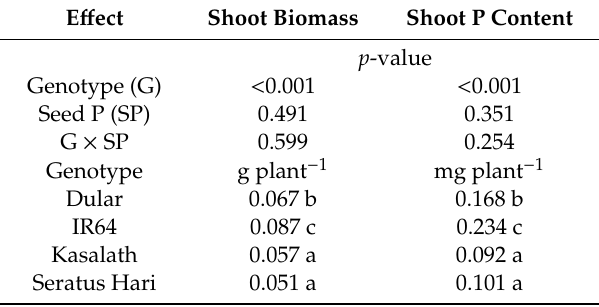
Table 3. ANOVA results for shoot biomass and shoot P content in Experiment 1 (Gleysol). Treatments that share a common letter within a column in the main e ff ect of “genotype” are not significantly di ff erent at p ≤